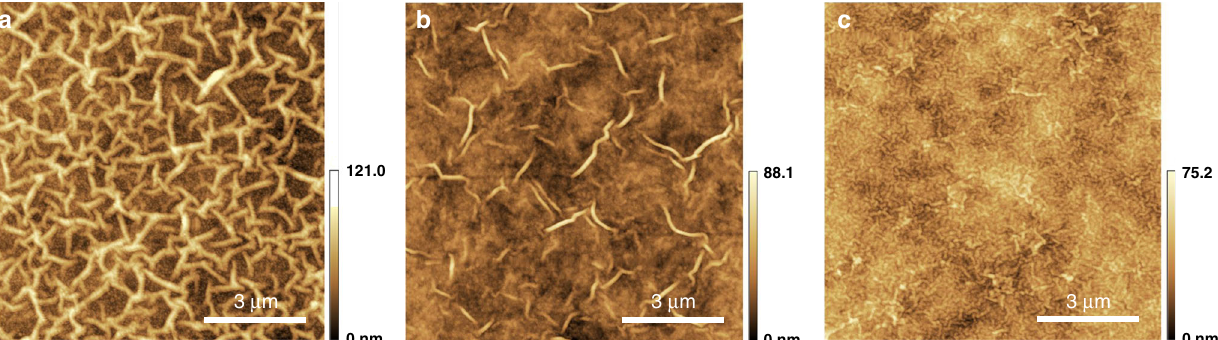
Fig. 5 Effects of dendrimer porous layers on the morphology of asymmetric polyamide nano fi lm. a – c Morphology of asymmetric polyamide nano fi lm supported by PSF-G4D-1 ( a ), PSF-G4D-2 ( b ), and PSF-G4D-3 ( c ). Table 1 Solid surface energy and mean effective pore